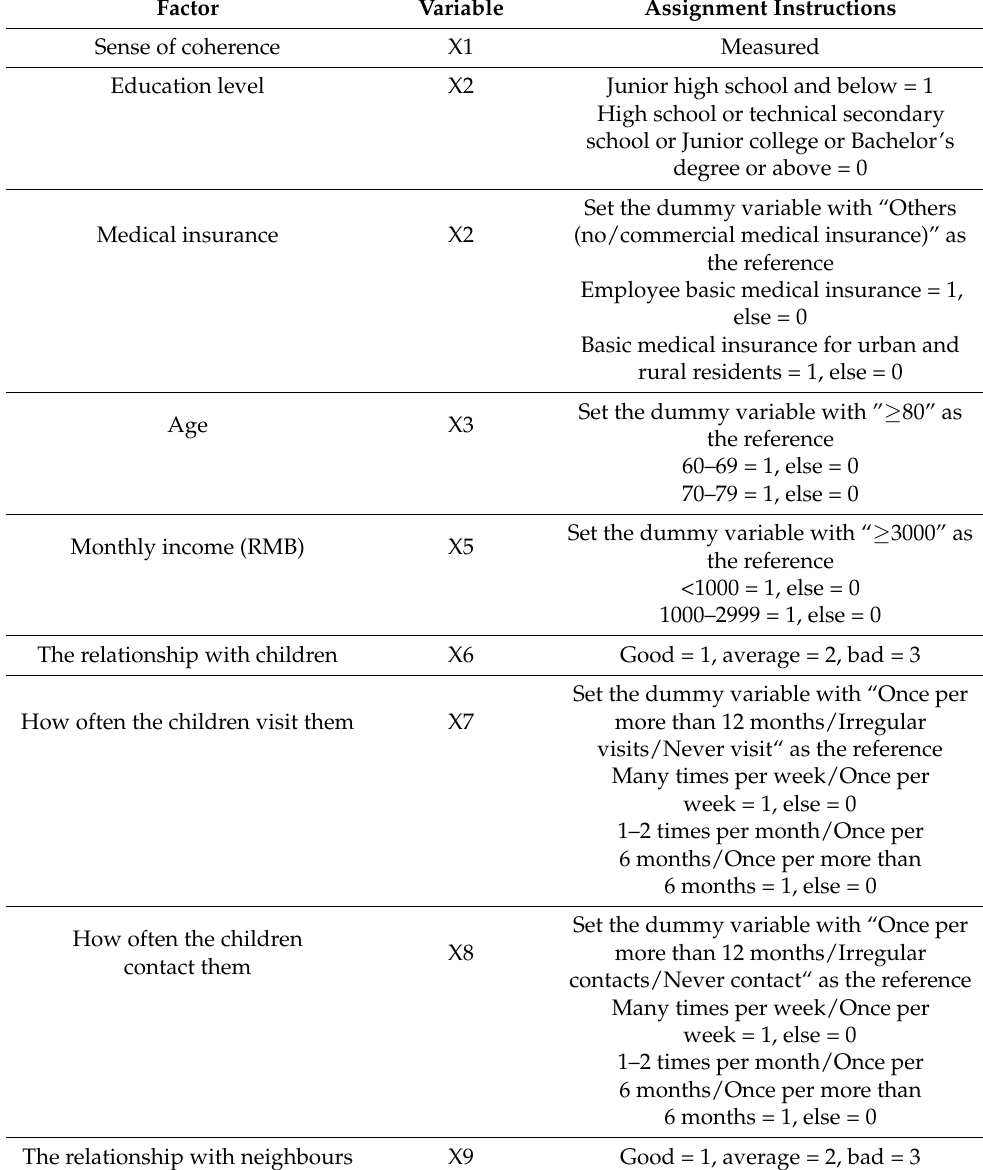
Table 9. The dummy variable assignment of multivariate logistic